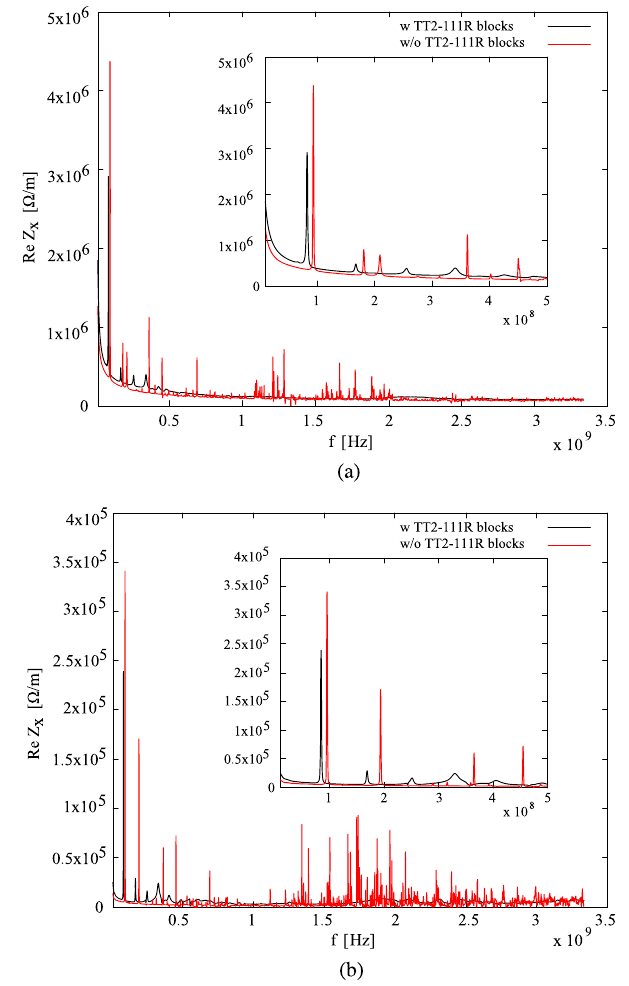
FIG. 6. Transverse dipolar impedance of the TCT real structure model calculated with G dfid L , for (a) 3 mm of half gap and (b) 8 mm half gap collimators, with tungsten jaws. The inset layers focus on the low frequency HOMs up to 500 MHz. The red curves correspond to the simulated structures without TT2-111R ferrite blocks, whereas the black ones to simulated structures with ferrite blocks. The HOMs characteristic frequencies are clearly shown to shift downward as an effect of the ferrite so as the HOMs shunt impedances being damped.